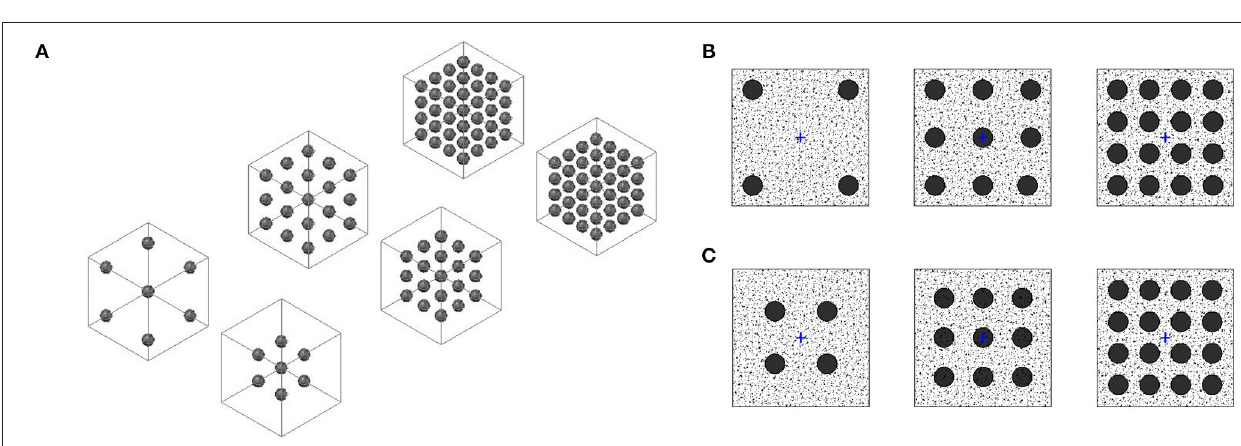
FIGURE 2 | Lattice-like patterns of the two batches of specimens with 8/27/64 inclusions and constant or variable cement cover. (A) Axonometric view of the two batches. (B) Top view of the specimens of batch 1 (S8C/S27C/S64C) with constant cement cover. (C) Top view of the specimens of batch 2 (S8V/S27V/S64V) with variable cement